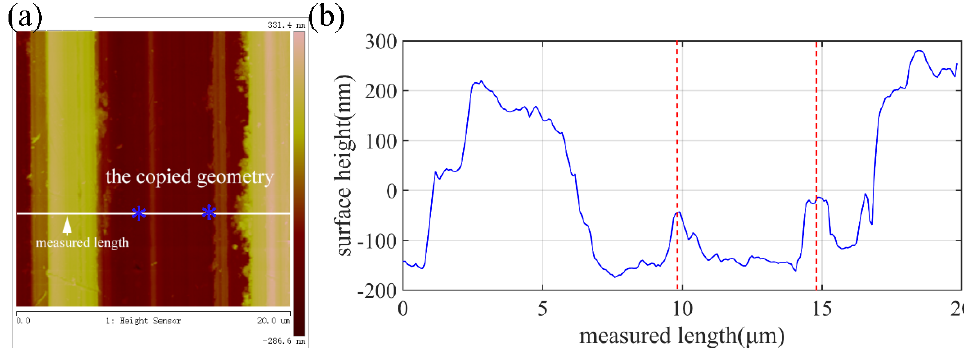
Figure 13. The SEM image of the diamond tool nose after cutting, where the tool wear can be found in the picture. Here, ( a ) shows that several micro-chipping appeared on the main cutting edge and ( b ) shows an enlarged area of the micro-chipping point.